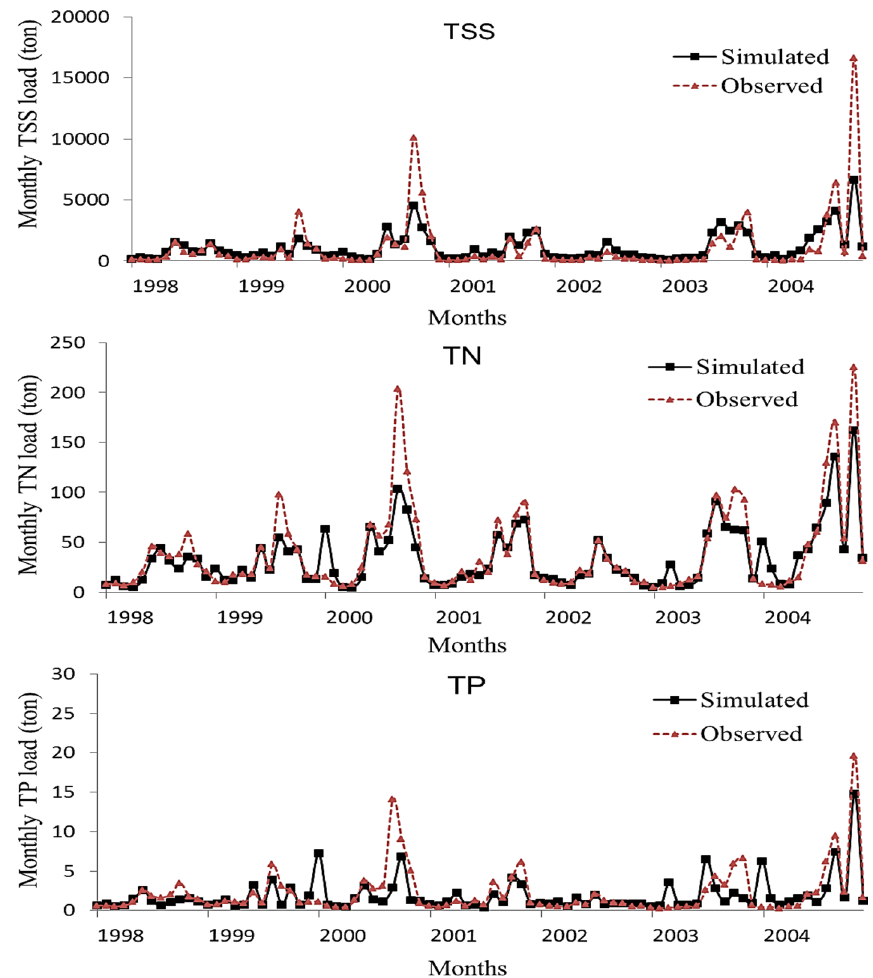
Fig. 5 Calibration between simulated and observed monthly TSS, TN and TP in the